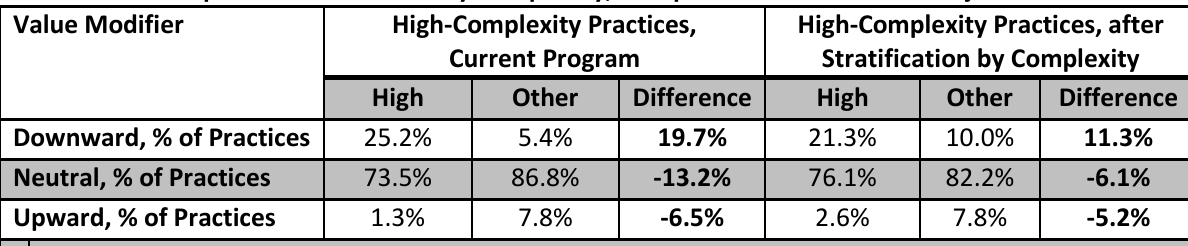
Table 10.21b. Impact of Stratification by Complexity, on Upward and Downward